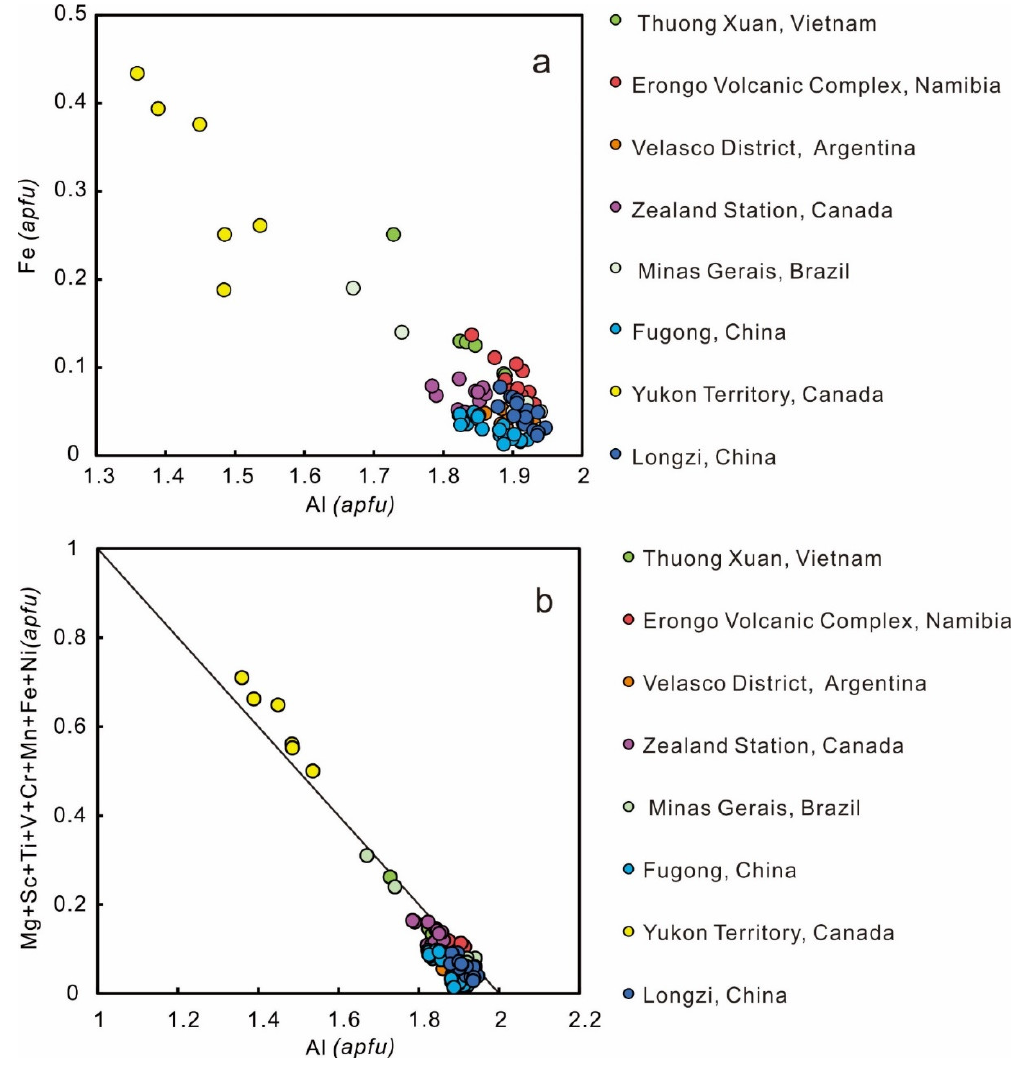
Figure 10. ( a ) Relationship between the major octahedral site ion (Al), and the principal substituent at the octahedral site (Fe), consistent with major Fe-Al substitution: There is a negative correlation between them, in atoms per formula unit (apfu). ( b ) Al versus the sum of its substituents in Y site, in atoms per formula unit (apfu). Other sources are [3,18,19,21,22,48,49].